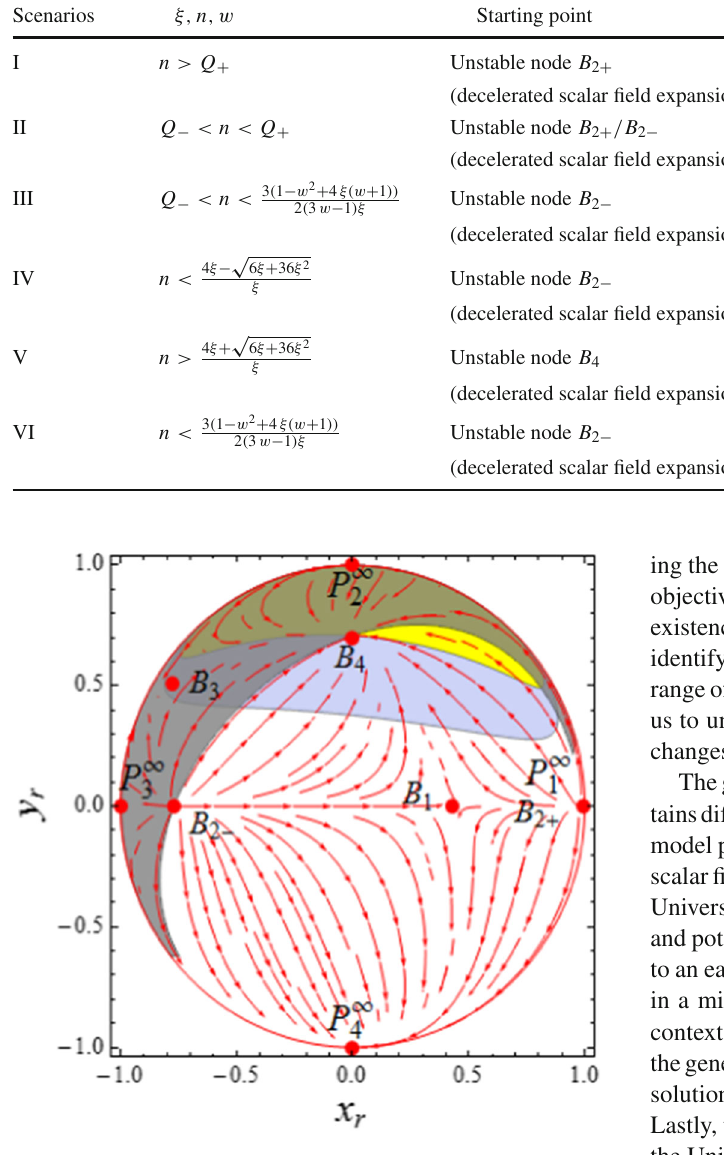
Fig. 3 A global phase portrait of the system (37)–(38) for the generic scenario (II) with w = 0 , n = 4 ,ξ = 0 . 1. The grey shaded region represents the non-physical region (i.e., (cid:8) m < 0). The yellow shaded region corresponds to the phantom like solution ( w eff < − 1) and the blue shaded region corresponds to a quintessence like solution ( − 1 < w < − 1 eff 3